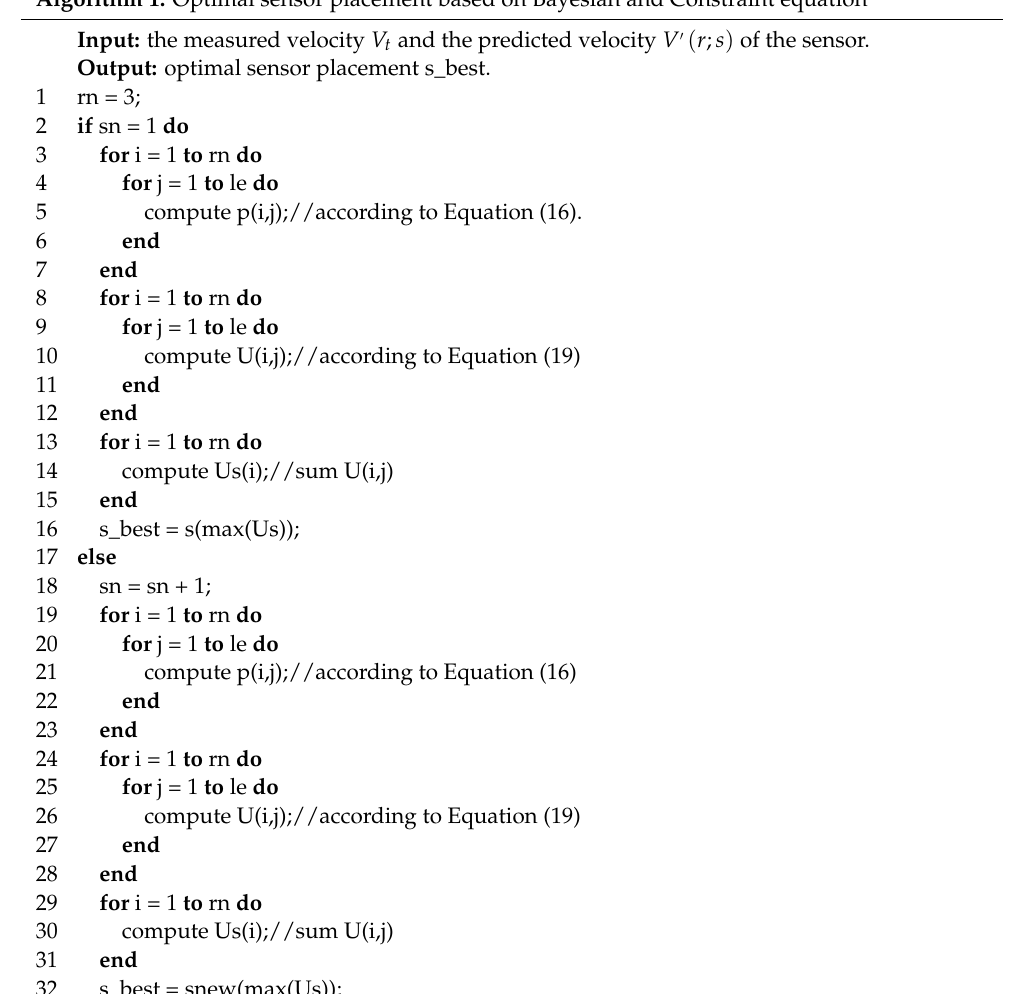
Algorithm 1: Optimal sensor placement based on Bayesian and Constraint